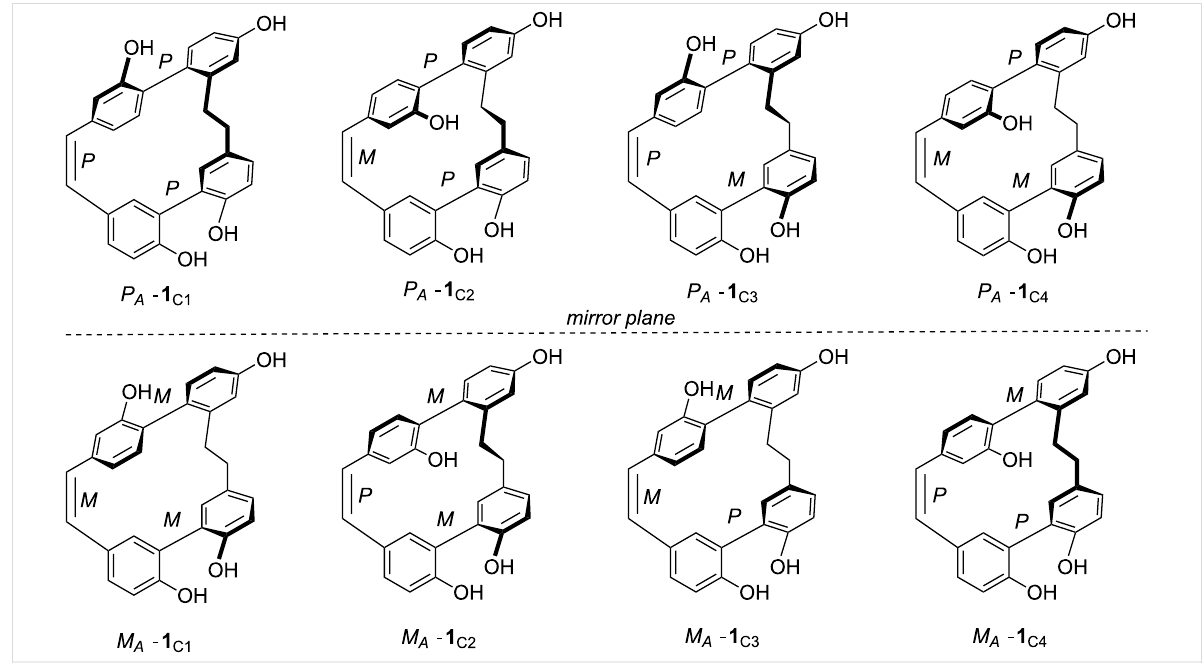
Figure 2: Possible stereoisomers of 1 as conformers C1–C4 relative to the configurationally stable biaryl axis A with the stereo descriptors P or M